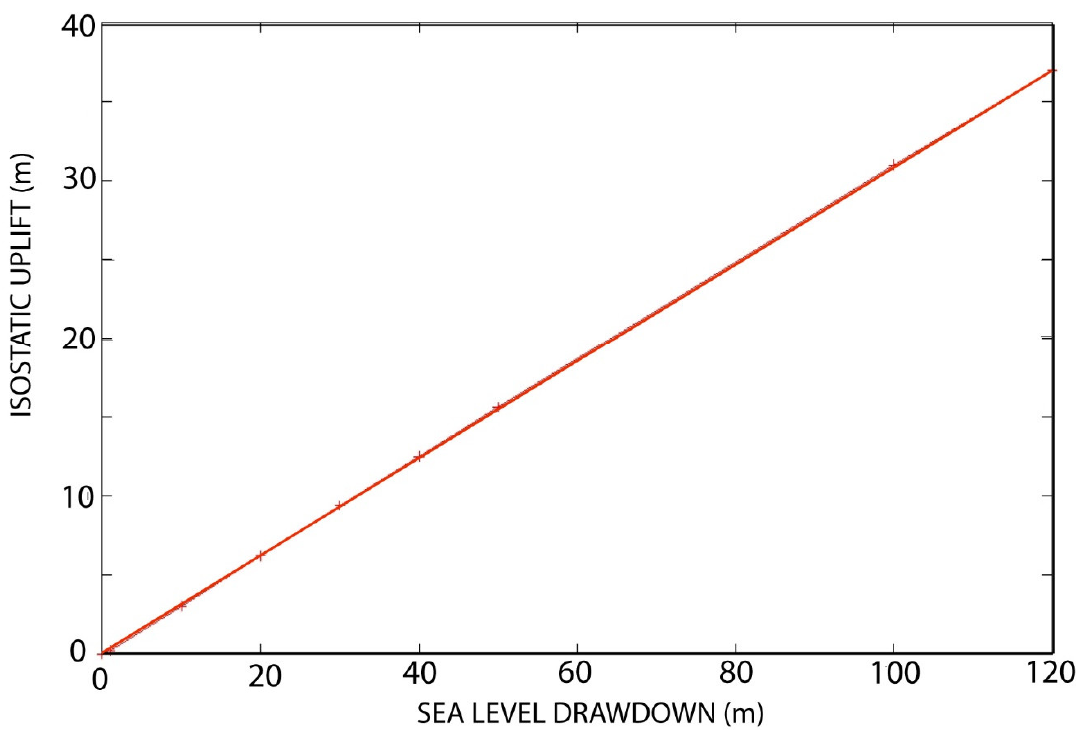
Figure 6. Coastal uplift due to isostatic rebound triggered by sea-level unloading. T e = 15 km. A relatively “small” abrupt mass unloading (S = 0.2 × 10 6 m 2 equivalent to 0.2 km 3 displaced volume) that cause a 1 m uplift in approximately 10 kyr generates a mean uplift rate V U of 0.1 mm/yr (Figure 5b). This is 100 times smaller than the uplift rate caused by a giant landslide as the one that occurred 872 kyr ago in Tahiti. In this case, the expected uplift is ~100 m and the resulting mean uplift rate is V U = 10 mm/yr (Figure 5a). The isostatic adjustment was also calculated perpendicularly to the one presented in Figures 3–5 and is presented in Figure 7. More precisely, in Figure 7b, the isostatic rebound is modeled in the area of the landslide scar (see Figure 1a for location) and uplift is estimated. In Figure 7a, the isostatic adjustment is modeled where the landslide deposit can be observed (see Figure 1a for location) and significant subsidence is